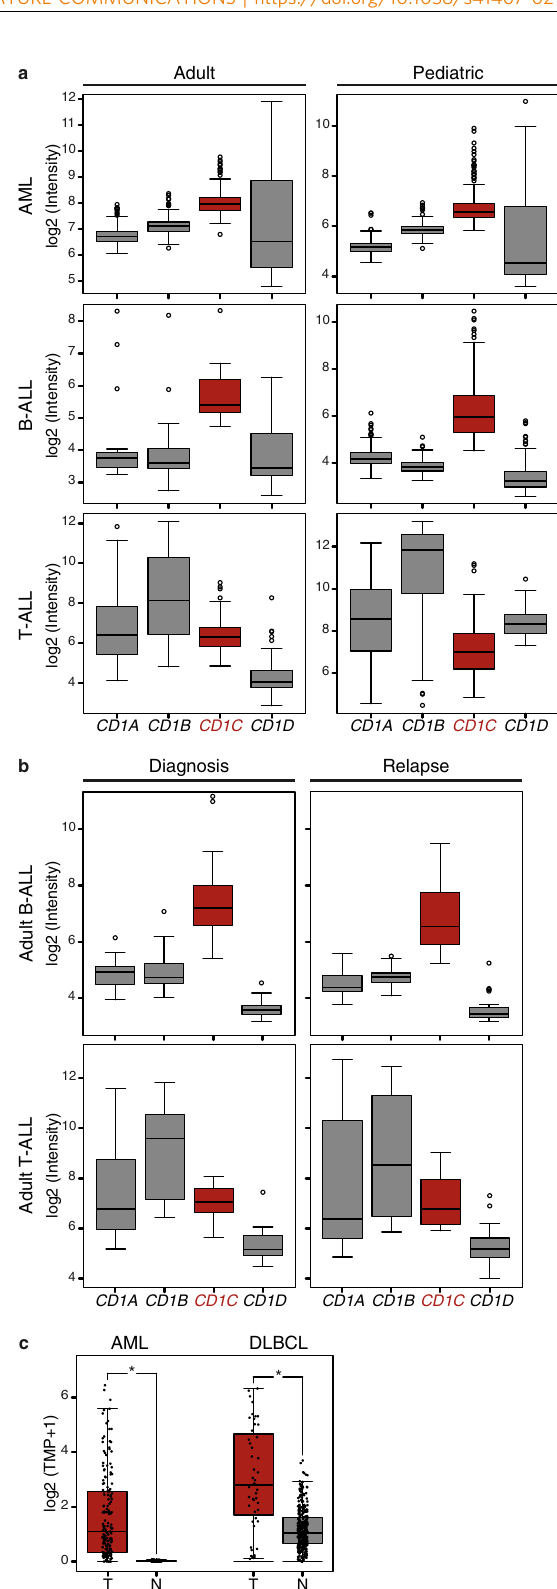
technology to prevent endogenous CD1 expression, prior to TCR transfer 6 (Supplementary Fig. 1d, e). Flow cytometry detection of the transduced chimeric TCRs by anti-mouse TCR C β mono- clonal antibody (mAb) showed that four TCRs (DN4.99, PZP8A6, DN4.2, and P8E3) were ef fi ciently expressed on the surface of the transduced Jurkat 76 β 2m - cells (Fig. 2a).